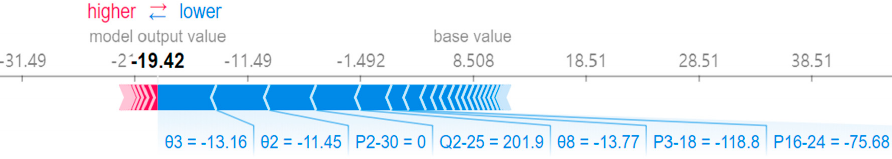
Figure 8. Interpretability of a prediction produced by AutoML on the Yunnan.